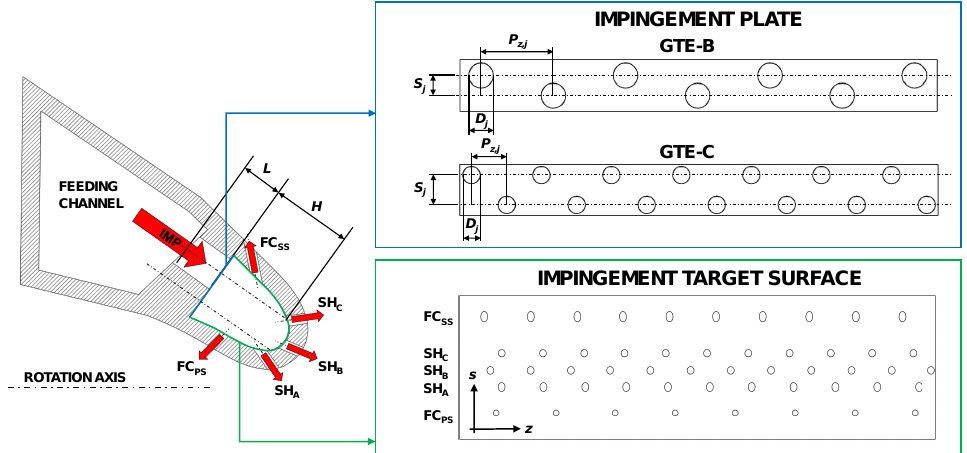
Figure 1. Scheme of the cooling